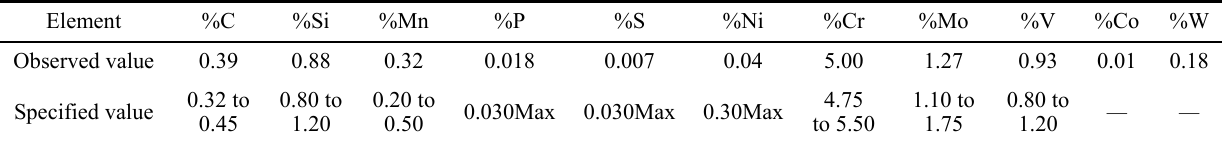
Table 1 Chemical composition of HDS steel grade AISI H13 in weight% [15]. Element %C Observed value Specified